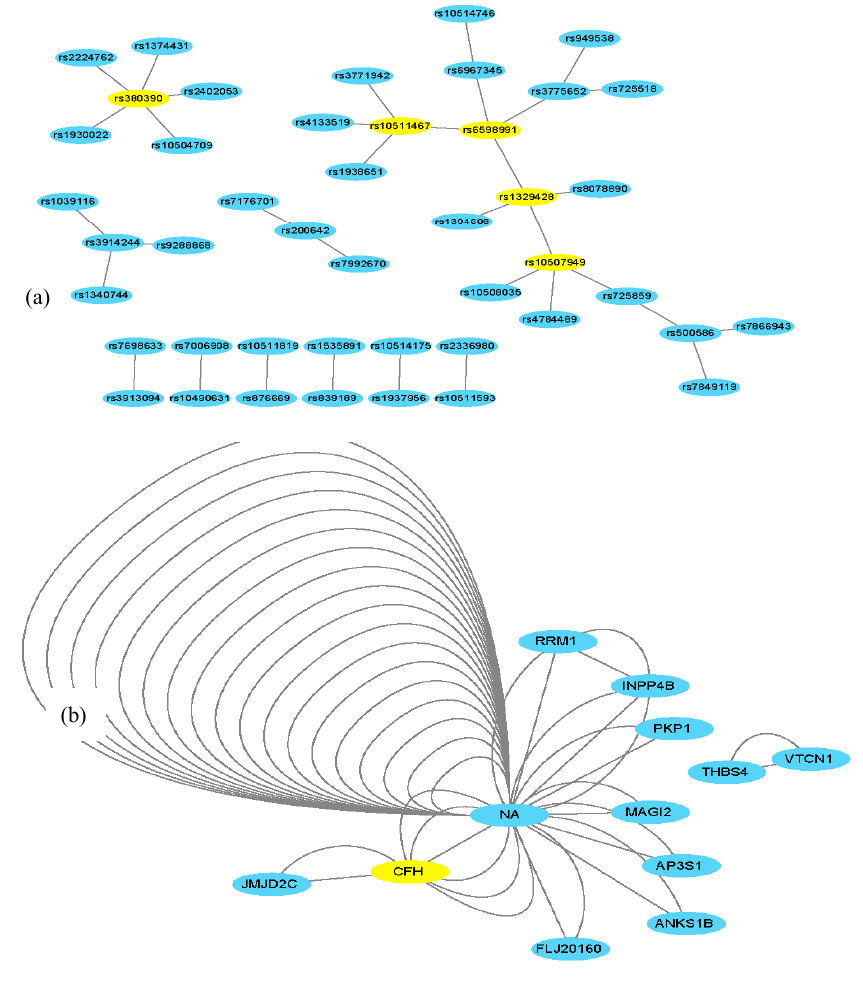
Figure 4. 2-way SNP and a representative gene network. ( a ) There are 35 edges and 45 nodes in Figure 4a, where each node denotes a SNP locus. An edge represents a 2-way SNP combination that has a strong association with the phenotype. The yellow SNPs (nodes) have been reported to be associated with age-related macular degeneration (AMD). ( b ) In Figure 4b, the nodes and edges are mapped from nodes and edges from Figure 4a, in which a node denotes a gene, and each edge represents a 2-way SNP combination that is mapped to two genes. NA denotes non-gene coding regions; there are multiple NA–NA edges because multiple SNP–SNP pairs were mapped to non-gene-coding regions. The greater the number of edges between two gene nodes, the more the SNP combination maps into the two genes. The yellow genes (nodes) are believed to be associated with AMD. In node NA, there are many edges, which means there are multiple SNP combinations in the non-coding region.